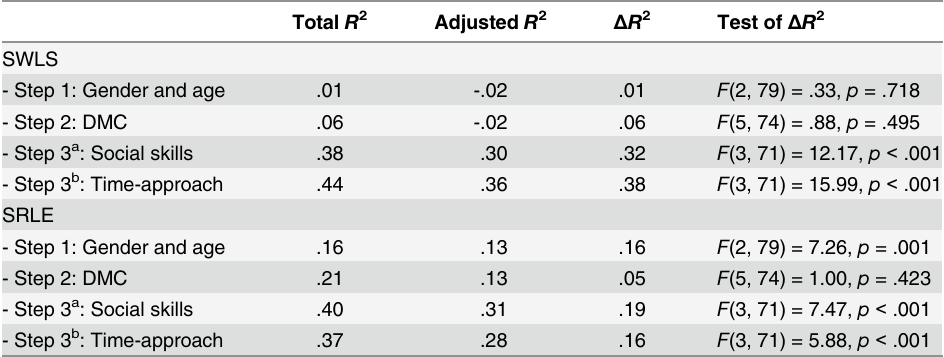
Table 5. Hierarchical regression of SWLS and SRLE — Study 2 (N =